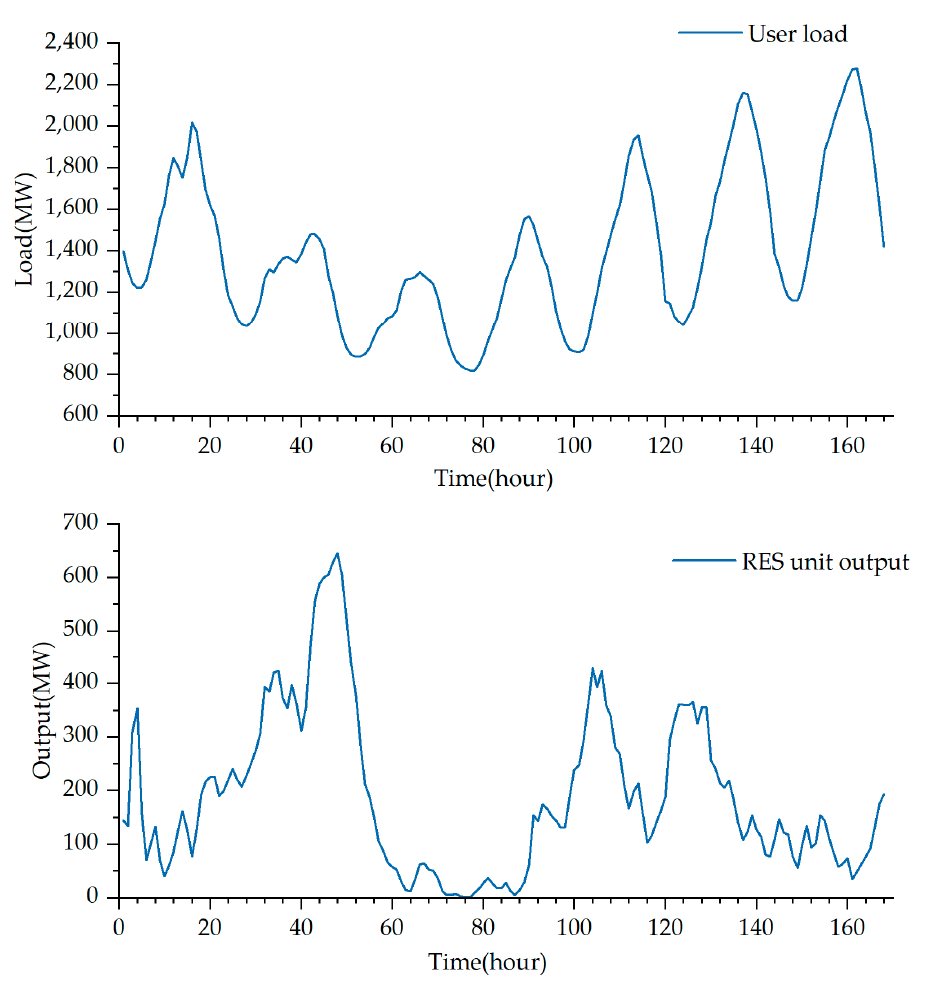
Figure 3. User load forecast and the output forecast of the renewable energy generator.